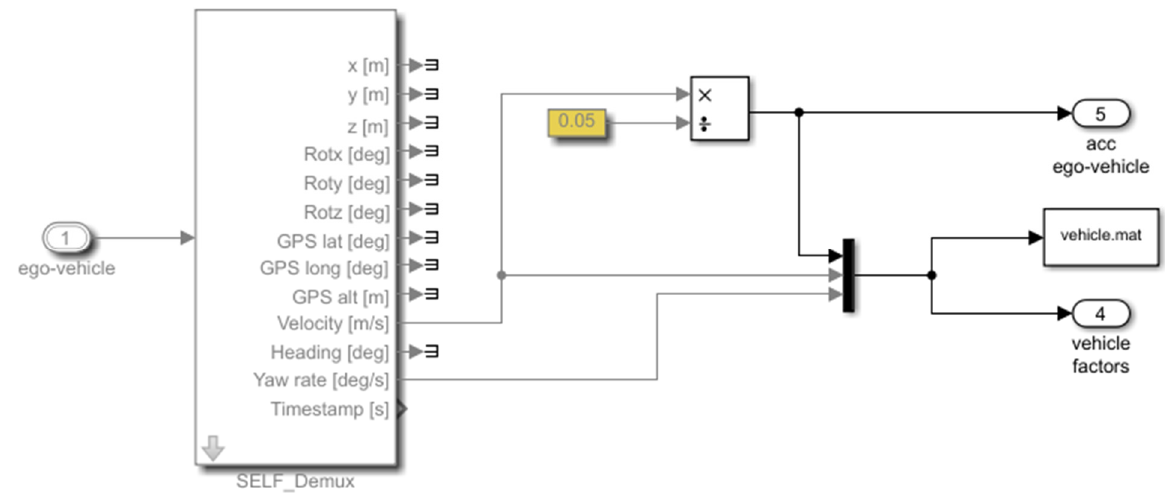
Figure 11. Estimation of vehicle-related factors in Simulink.